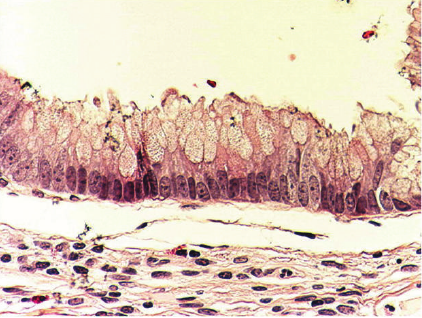
Figure 2: Photomicrograph showing appendiceal mucosal muci- nous hyperplasia with no cytological epithelial atypia (original magnification × 20, hematoxylin and eosin